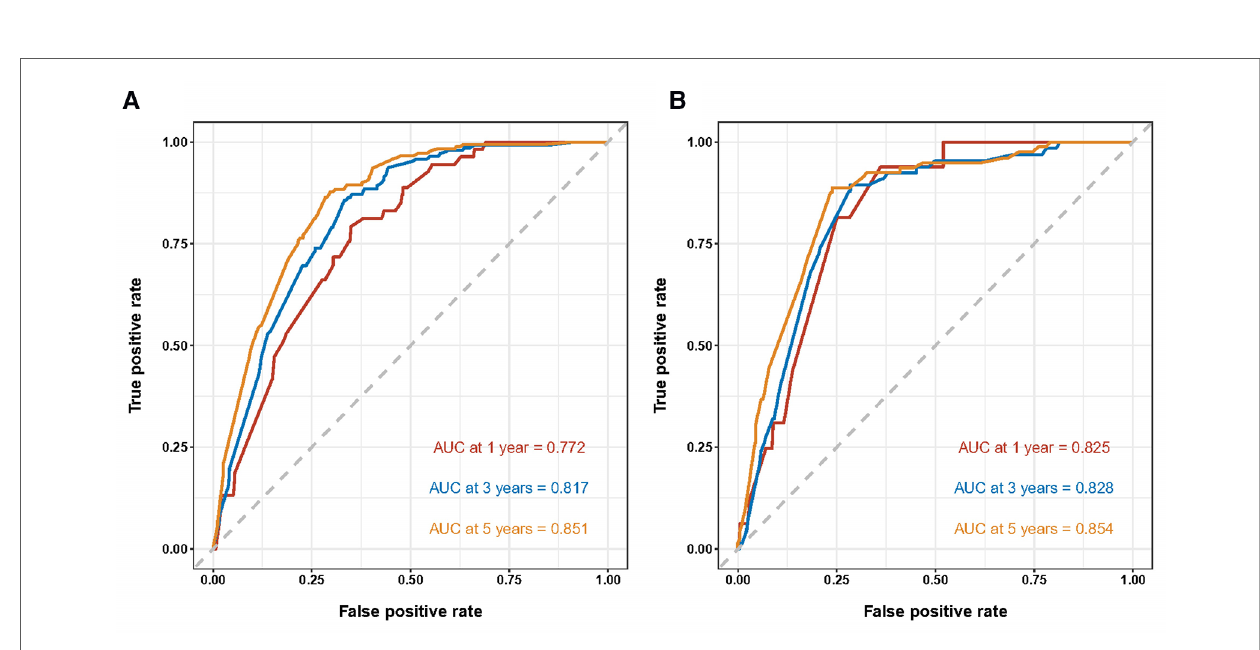
FIGURE 5 ROC curves of the nomogram for predicting 1-, 3-, and 5-year cancer-speci fi c survival in the training cohort ( A ) and the validation cohort ( B